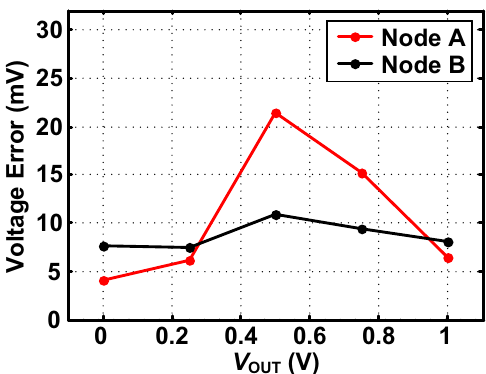
Figure 9. The voltage error caused by the current inject of switches.